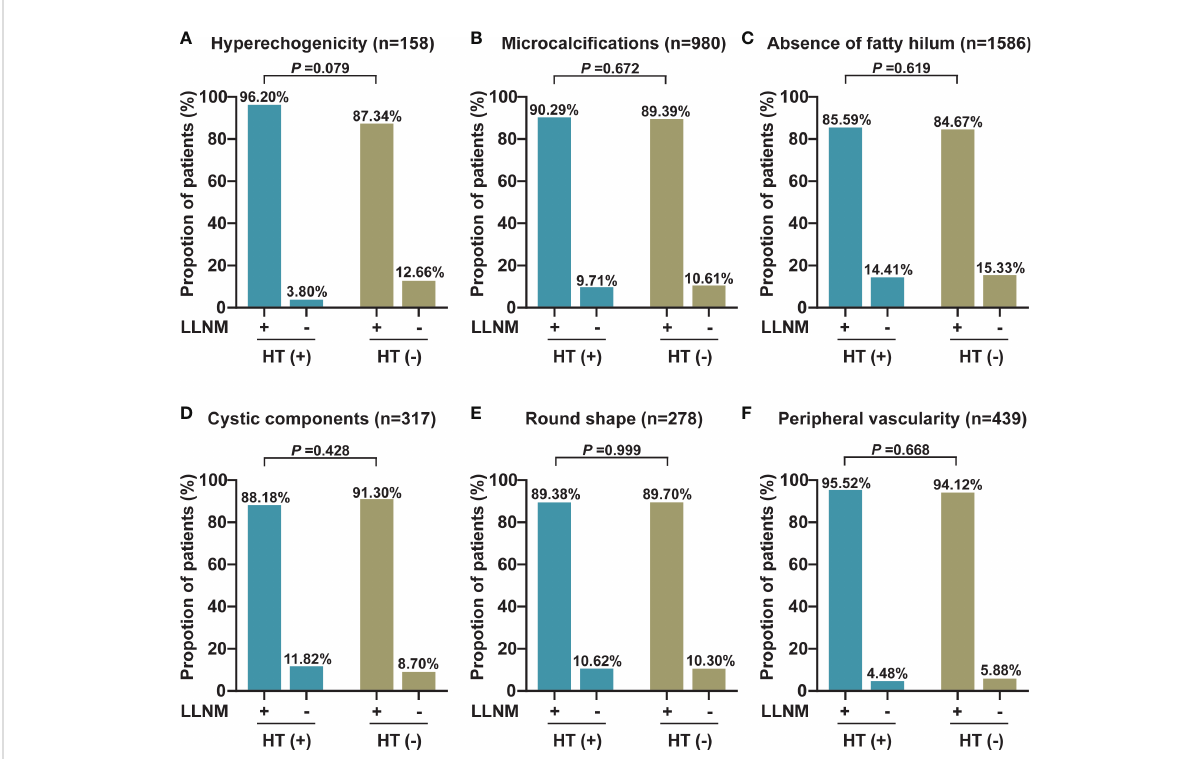
FIGURE 3 The proportion of each abnormal US feature between malignant and benign lateral LNs in PTC patients with or without HT. (A) The proportion of hyperechogenicity ( n = 158). (B) The proportion of microcalci fi cations ( n = 980). (C) The proportion of the absence of fatty hilum ( n = 1,586). (D) The proportion of cystic components ( n = 317). (E) The proportion of round shape ( n = 278). (F) The proportion of peripheral vascularity ( n = 439). LLNM, lateral lymph node metastasis; HT, Hashimoto ’ s